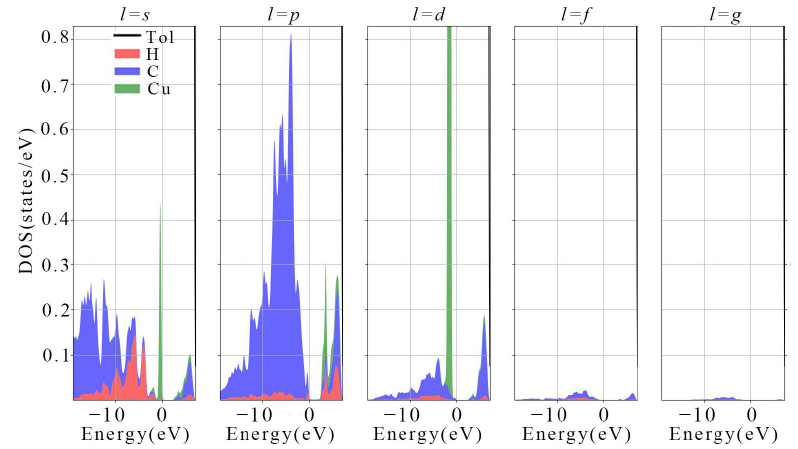
Figure 9. T4 point PDOS map, 0 points can represent the Fermi level.